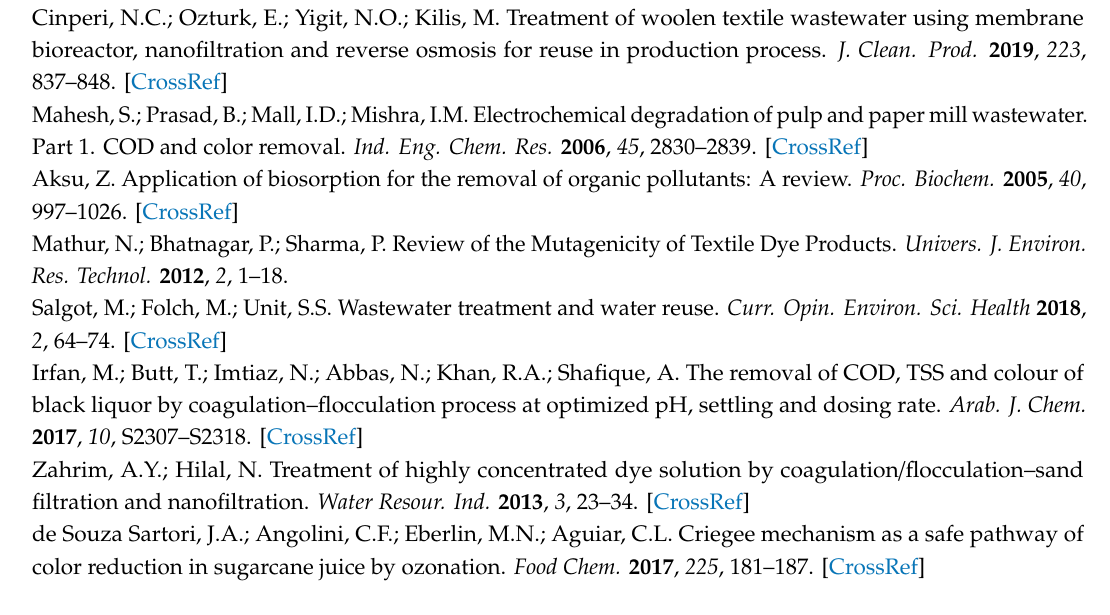
Figure S1: (a) N 2 adsorption / desorption isotherms and (b) pore size distribution of the adsorbents, Figure S2: The e ff ect of the temperature on the dye removal with time (dosage level of 0.6 g, initial dye concentration of 100 mg L − 1 and pH 5.5), Figure S3: Adsorption isotherms on the MCC (dosage level of 0.6 g, pH 5.5 and adsorption temperature of 30 ◦ C), Table S1: Comparison with other relevant